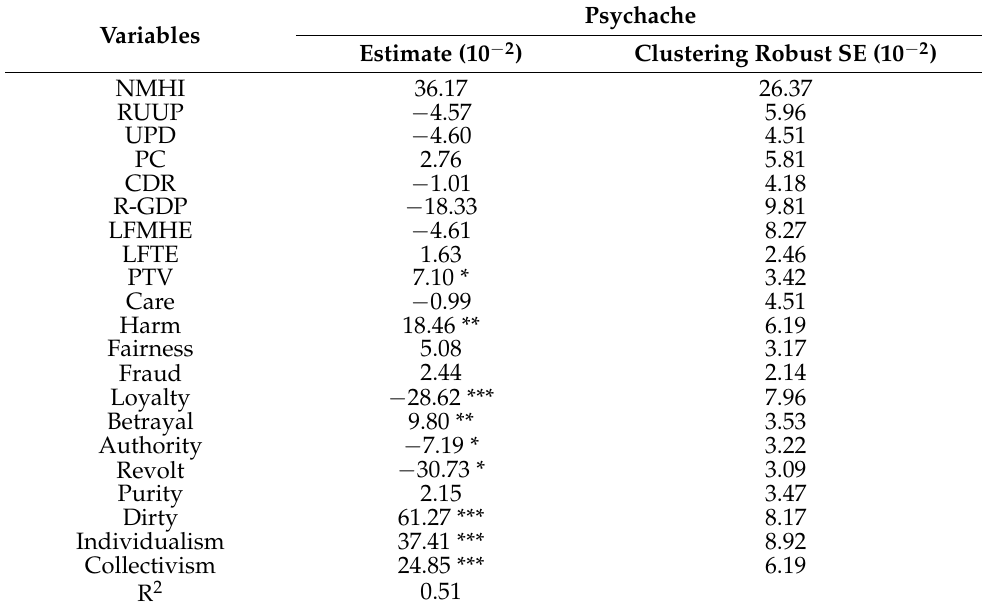
Table 5. Regression outcomes of two-way FE model of clustering robust standard errors with replacement